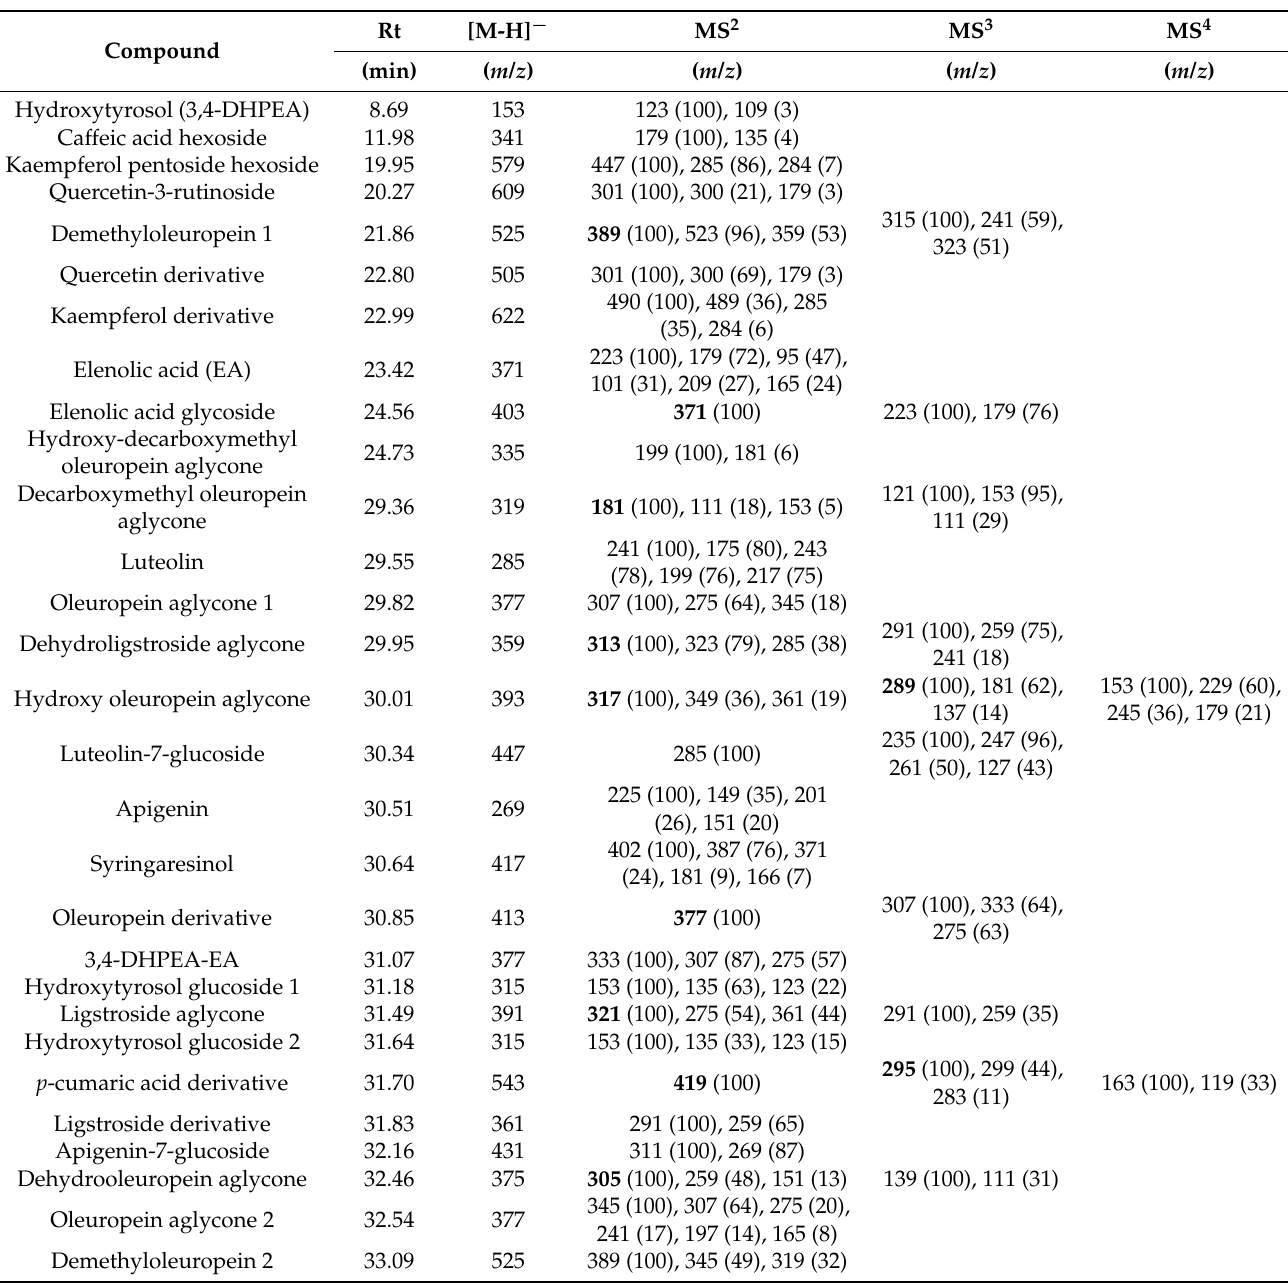
Table 1. Fragmentations of individual